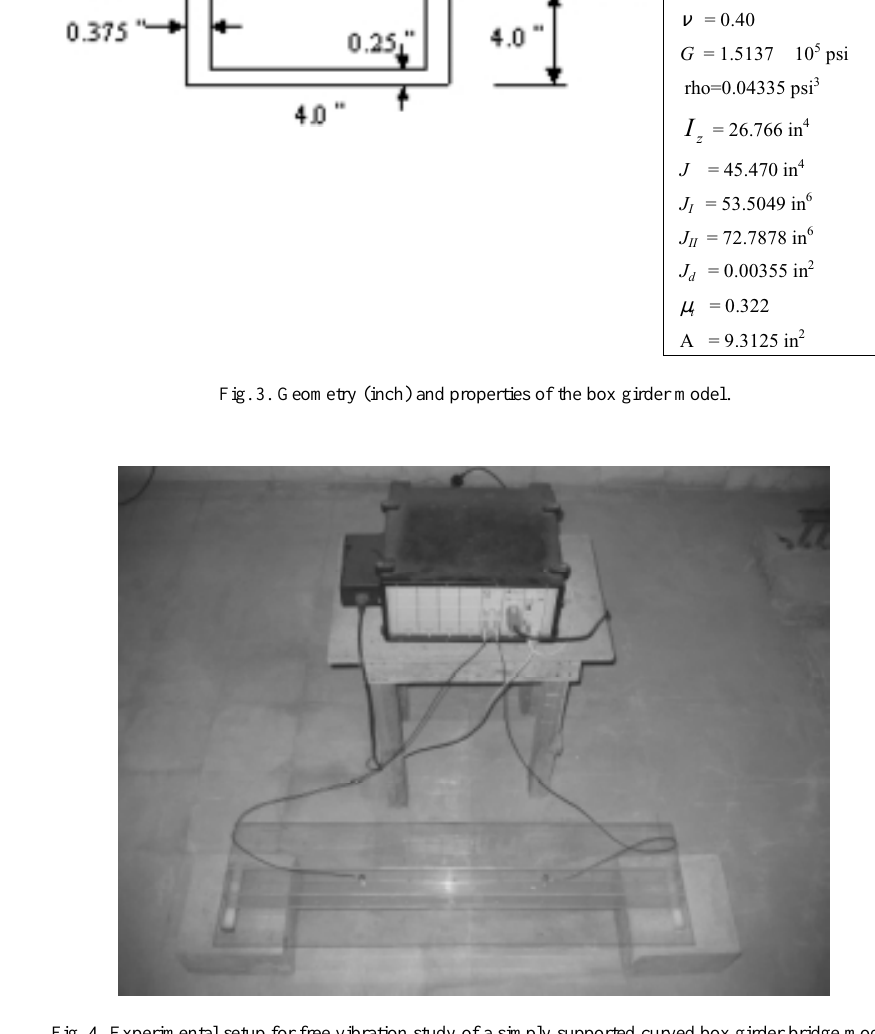
Fig. 4. Experimental setup for free vibration study of a simply supported curved box girder bridge